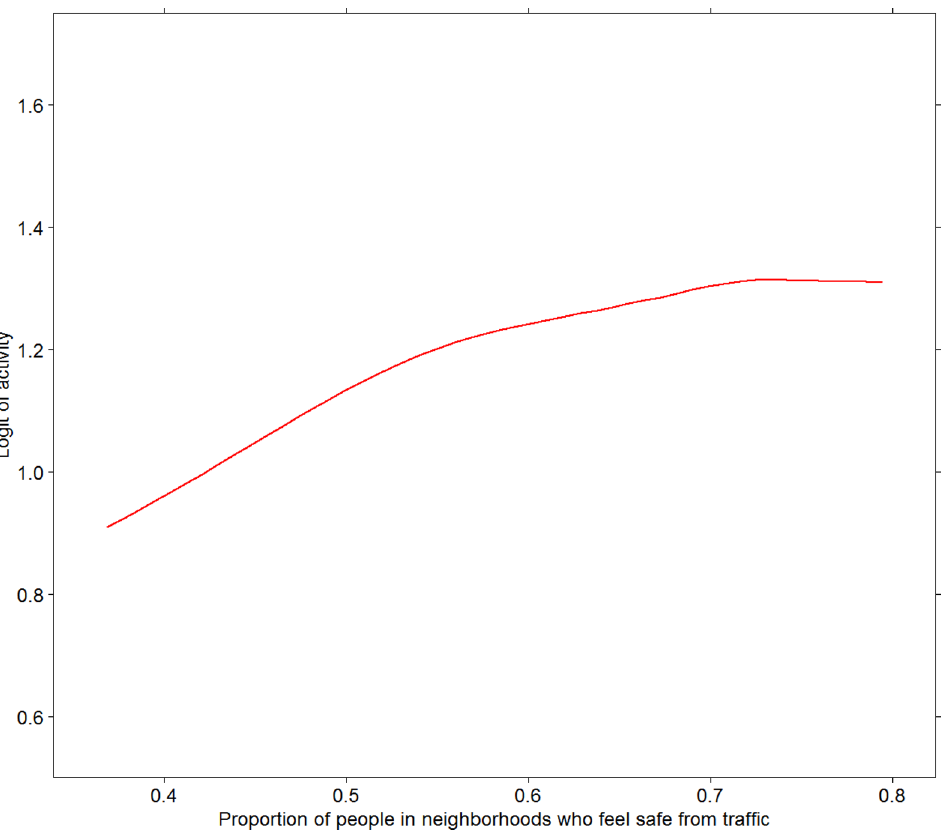
Figure 3. Prevalence of PA in 2009 in relation to levels of traffic safety in 2006. Prevalence of PA is measured as crude logit. Relationship depicted by a Loess curve based on 1 degree of freedom.